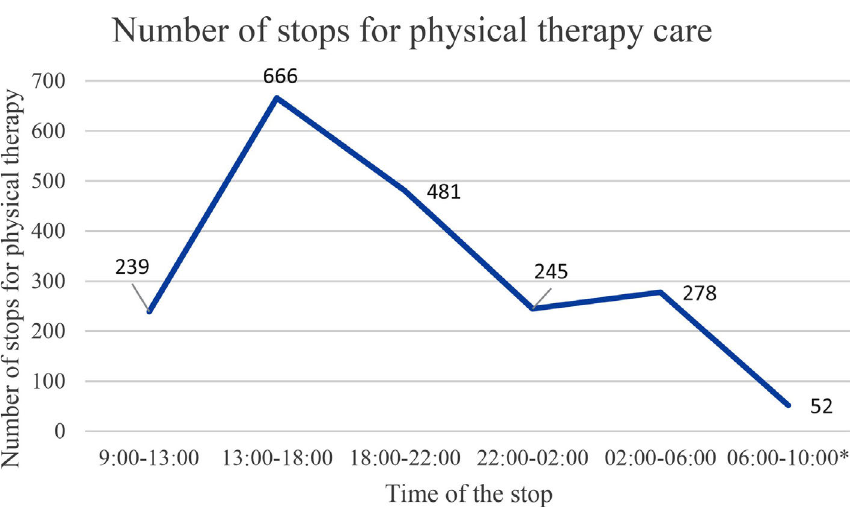
Figure 2 - Number distribution of physical therapy care service for 24 h. * The tests ended at 9:00, but the physical therapy assistance went on until 10:00.